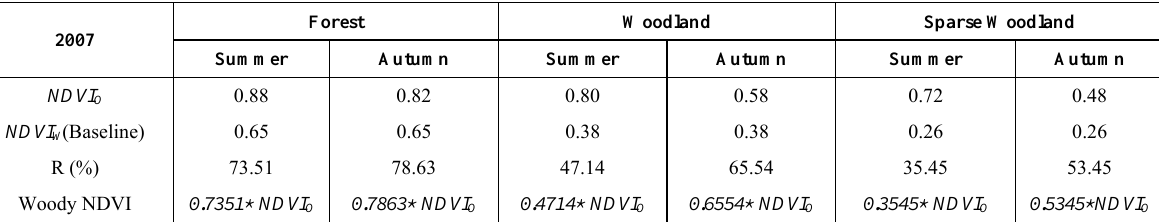
Table 2. Woody NDVI percentage in summer and autumn